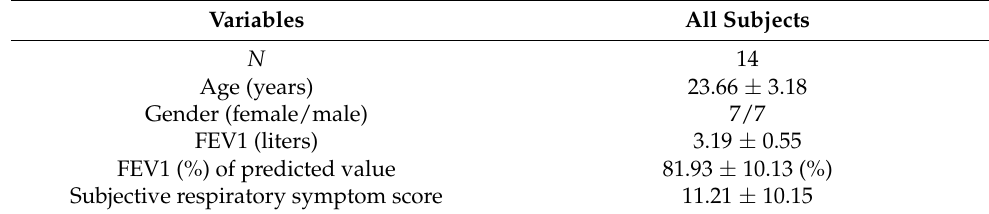
Table 1. Baseline characteristics of the study participants (N = 14, mean ± SD).